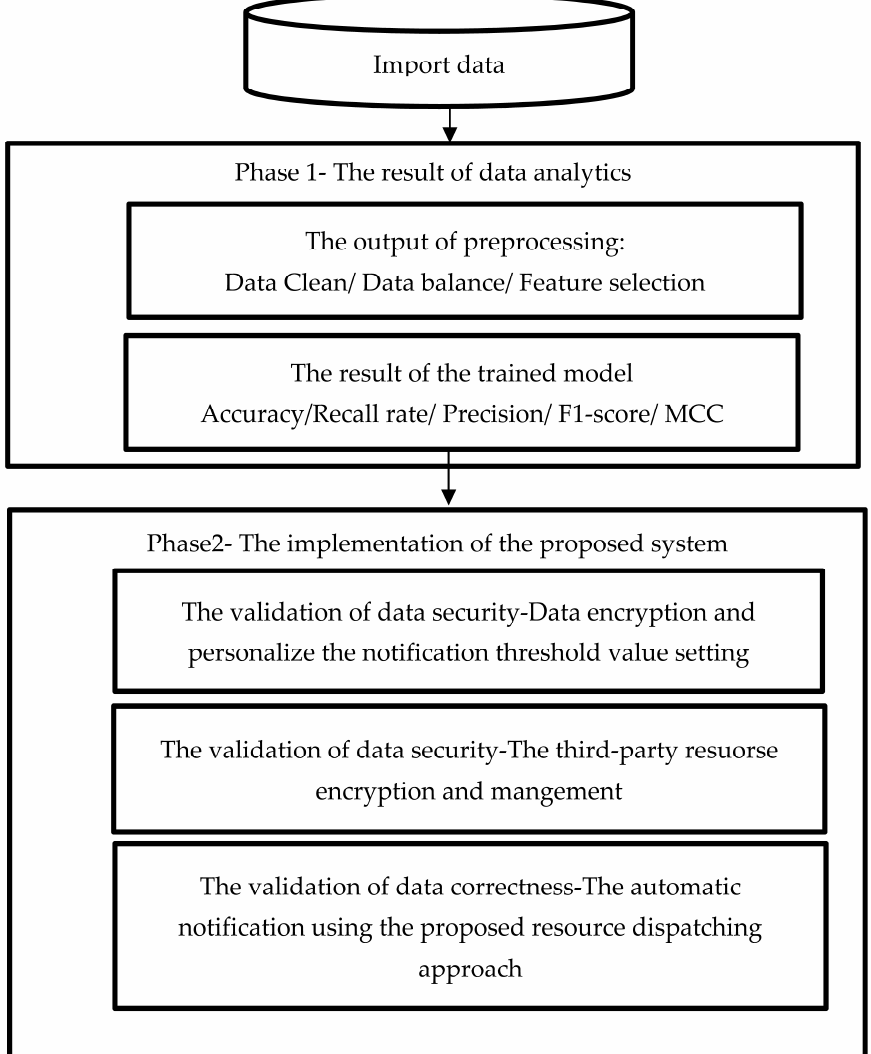
Figure 6. The flowchart of the experiment.